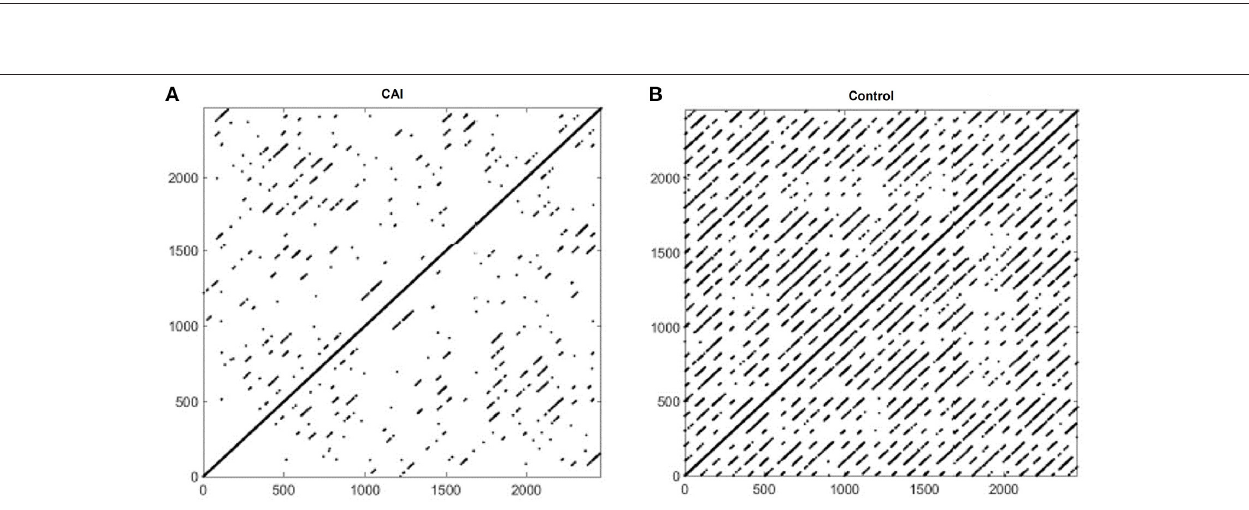
FIGURE 1 | An illustration of the procedures to convert a time series to a 3-dimensional phase space before it is projected to a recurrence plot. A point (red dot) and two other points in a later time (green and blue dots) are identified in the original time series (A) . These three dots are then embedded in a 3-dimensional phase space formed by the red, green, and blue axes (B) . Each location in the phase space is viewed as a “state” of the dynamic system. The same embedding procedure is repeated for every point on the original time series, and a trajectory will be formed in the phase space. The phase space trajectory is then projected to the recurrence plot (C) . The recurrence plot is essentially an N-by-N grid, where N is the number of points in the original time series. The black dots on the grid represent recurrence points. When the system repeats specific sequences of stats in the phase space (i.e., the “pattern” of the phase space trajectory repeats), recurrence points will form diagonal lines of the recurrence plot. When the system stays in a similar state for a period (e.g., the part of the phase trajectory marked by the dashed circle in (B) ), recurrence points will form vertical lines. The bottom right corner of the recurrence plot (C) is zoomed in to show the vertical lines. In this example the embedding dimension was set artificially low and a relatively large distance threshold was used to facilitate conceptual understanding of the structures in the recurrence plot.